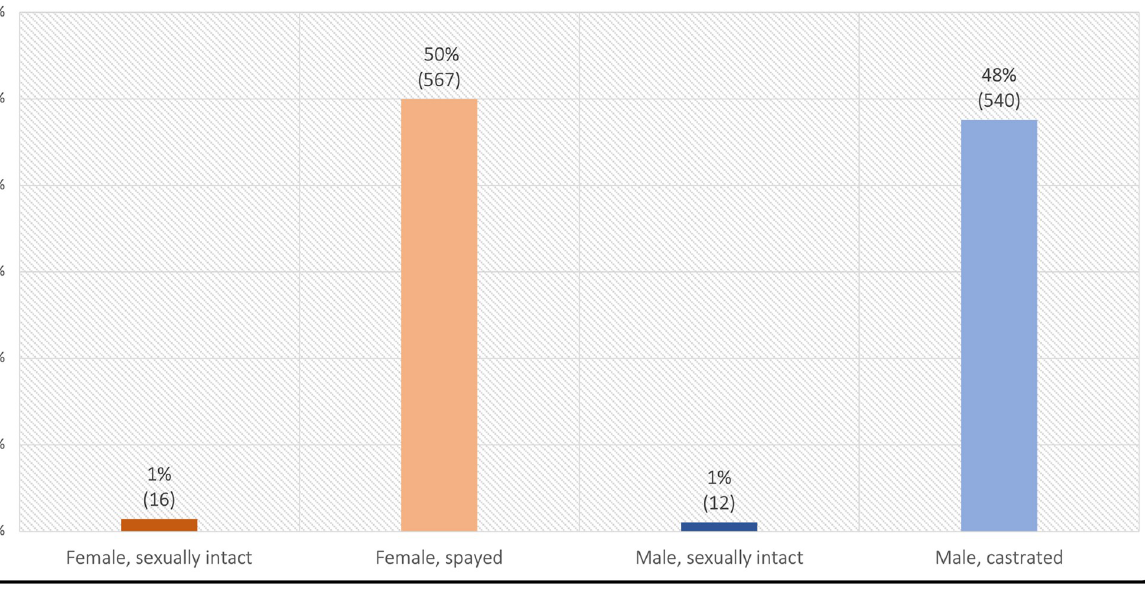
Fig 4. Sex/neuter status of 1,135 sampled